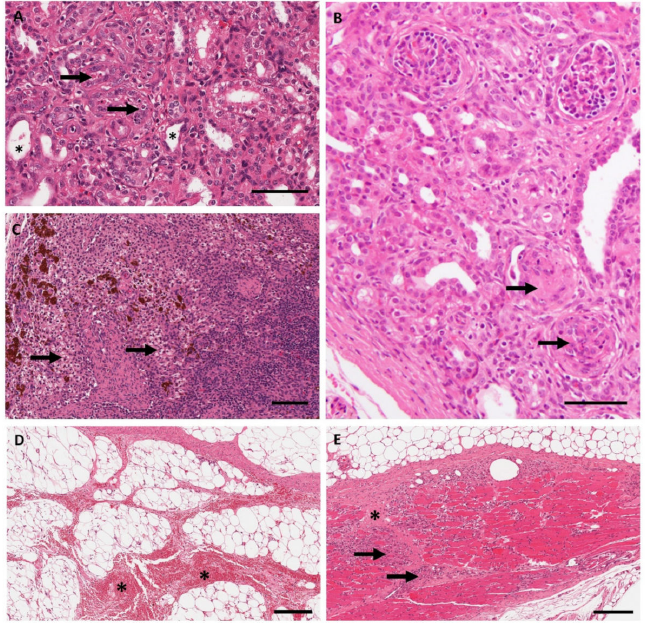
Figure 6. Histopathology findings. ( A ) Kidney, PND 43, H&E; Necrosis of tubular cells (arrow), tubular degeneration (asterisk). ( B ) Kidney, PND 51, H&E; Interstitial fibrosis and inflammatory cell infiltration, and glomerulosclerosis (arrow), ( C ) Lymph node, PND 51, H&E; Foamy macrophages (ar- row) and brown pigment in the sinus macrophages due to intramuscular iron injection. ( D ) Injection site, PND 37 (control), H&E; Hemorrhage (asterisk) in the subcutaneous adipose tissue. ( E ) Injection site, PND 43 (treated), H&E; Inflammation (arrow) and fibrosis (asterisk) of the panniculus muscle. (Scale bar: ( A – C ) = 100 µ M; ( D , E ) = 200 µ